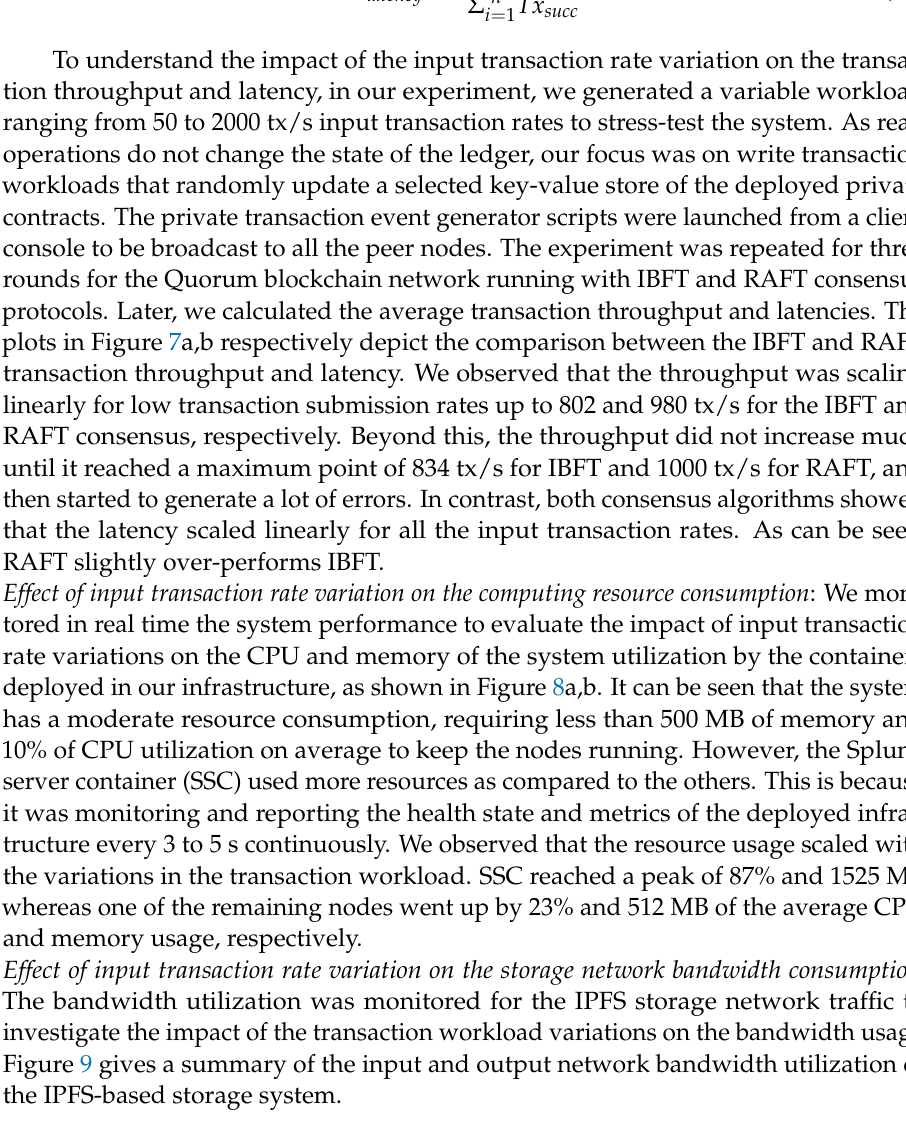
Table 5. Computation complexity of essential transactions interacting with the blockchain. Type of